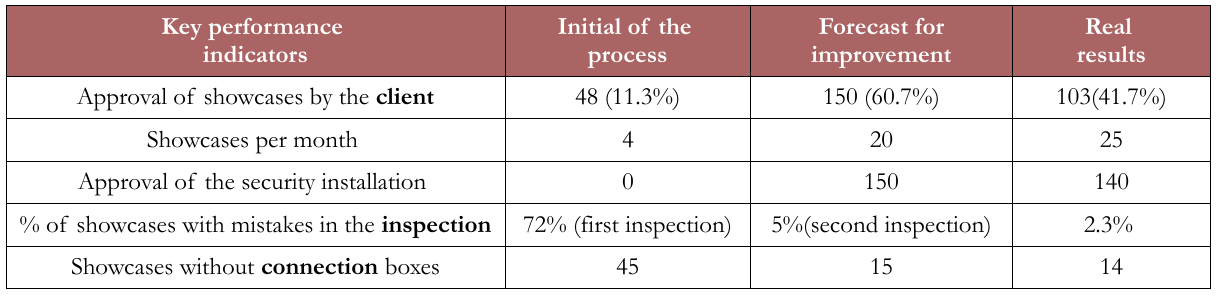
Table 7. Evolution of the approval of the security installation in